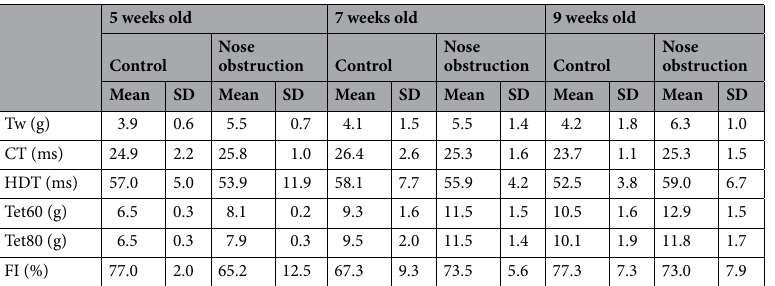
The number and percentage of fast IIa and IIb type muscle fibers are shown in Table 3. The fast-IIb type were found in greater amount than the fast-IIa type in both groups at all ages. There were no significant differences between the control and nose obstruction groups at any age for any of the IIa or IIb muscle fiber types; and there were no intragroup statistical differences for any of these muscle fiber types. At 5 weeks old, the diameter of slow-type, fast-type, and fast IIb type muscle fibers showed no significant dif- ferences between the control group and nose obstruction group, while the diameter of fast IIa type significantly increased in the nose obstruction group compared with the control group (Table 4; Fig. 3). At 7 weeks old, there